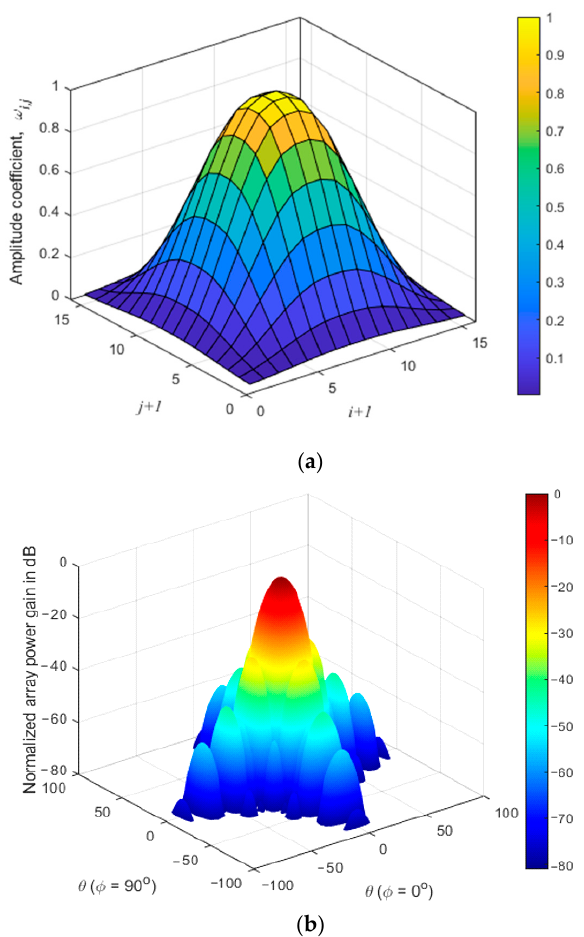
Figure 6. ( a ) 2D cross-linear extrapolated cosine-square window for 16 × 16 array. ( b ) Normalized array power pattern.